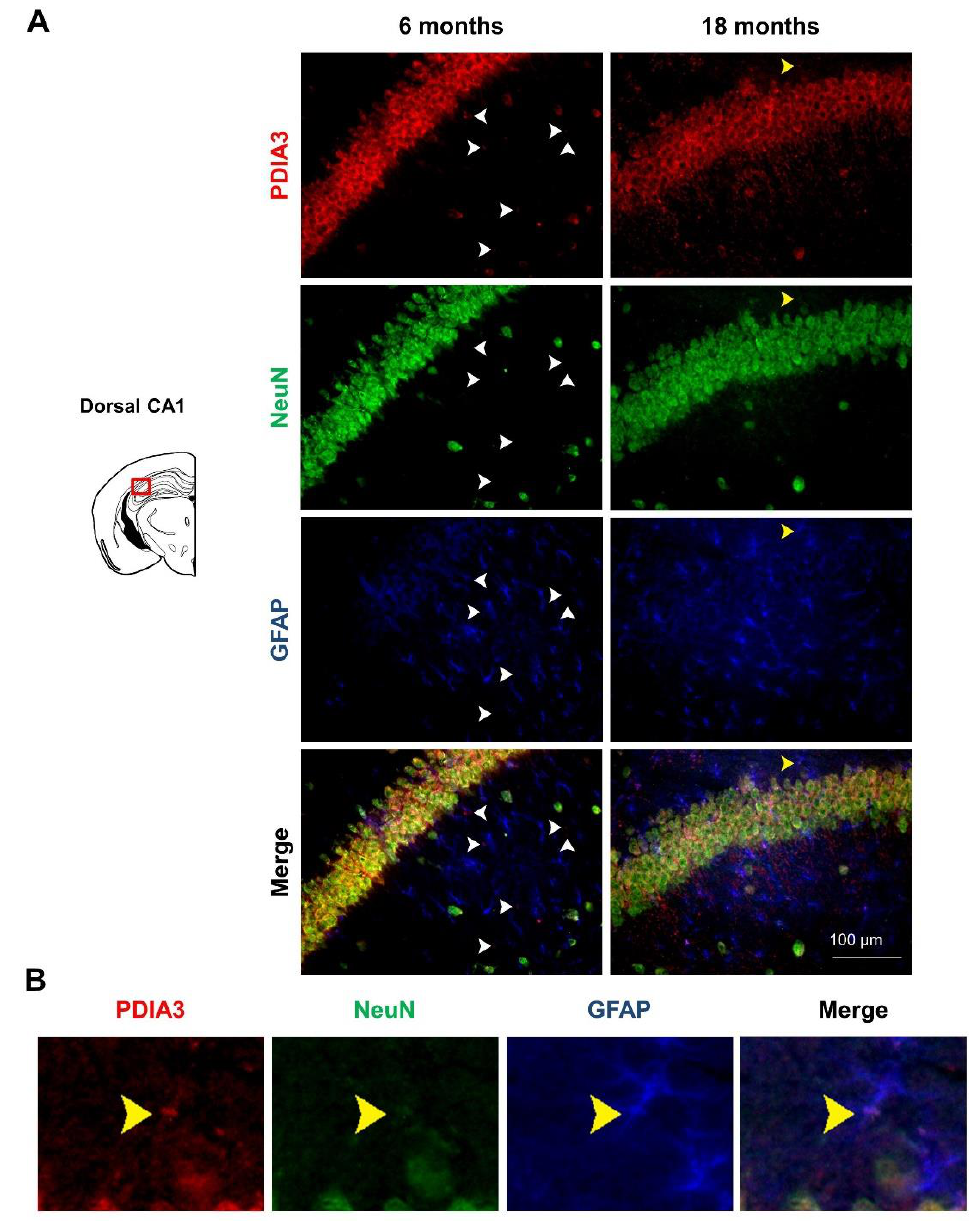
Figure 8. PDIA3-NeuN-GFAP protein levels observed in the dorsal CA1 region of the hippocampus of 3 × Tg-AD mice: ( A ) Representative microphotographs of PDIA3-NeuN-GFAP triple-fluorescent immunostaining (red, green, and blue, respectively) performed on brain slices of dorsal CA1 region of hippocampus collected from 6- and 18-month-old 3 × Tg-AD mice. The white arrows indicate the PDIA3 single-positive cells while the yellow arrows indicate the PDIA3-GFAP co-localization. Original magnification: 20 × ; scale bar was set at 100 µ m; ( B ) Representative microphotographs of PDIA3-GFAP co-localization in astrocytes from dorsal CA1 region of hippocampus of 18-month-old 3 × Tg-AD mice.